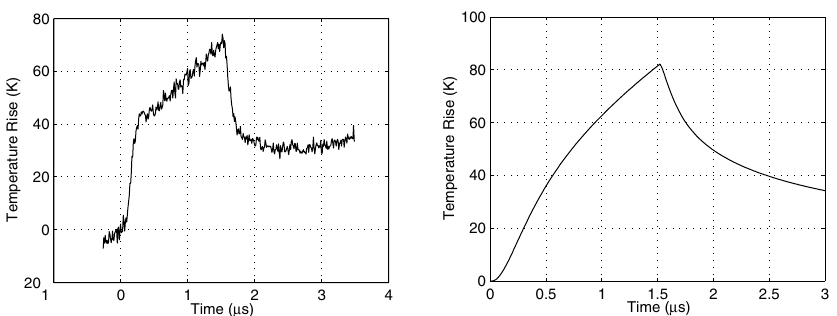
FIG. 24. Measured and theoretical prediction of maximum temperature rise on the end caps during a high-power pulse. Changes in amplitude and phase of the reflected TE assumed to be caused by temperature rise alone in this measurement. There is discussion of this assumption in the text. The theoretical prediction is based on a 7.3 MW power input. The rf pulse is initiated at time 0 (cid:3) s